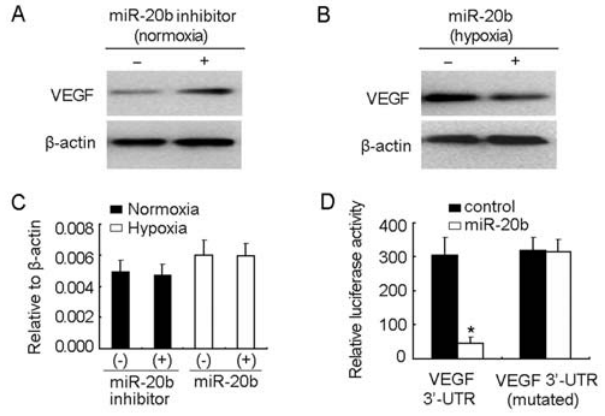
Figure 4. VEGF is targeted by miR-20b. (A) miR-20b inhibitor increased VEGF protein in normoxic H22 cells. miR-20b inhibitor or control oligonucleotide was transfected into normoxic H22 cells. 48 hr later, the cells were used to detected VEGF expression by Western blot. (B) miR-20b decreased VEGF protein in hypoxic H22 cells. miR-20b or control oligonucleotide was transfected into hypoxic H22 cells. 48 hr later, the cells were used to detect VEGF expression by Western blot. (C) miR-20b inhibitor or miR-20b did not affect the mRNA levels of VEGF. The cells of above (A) and (B) were used for real time RT-PCR to detect VEGF mRNA expression. (D) miR-20b targeted 3 9 -UTR of VEGF mRNA. The specificity of miR-20b to 3 9 -UTR of VEGF mRNA was identified as described in Methods . *, P , 0.01, compared with VEGF 3 9 -UTR group.